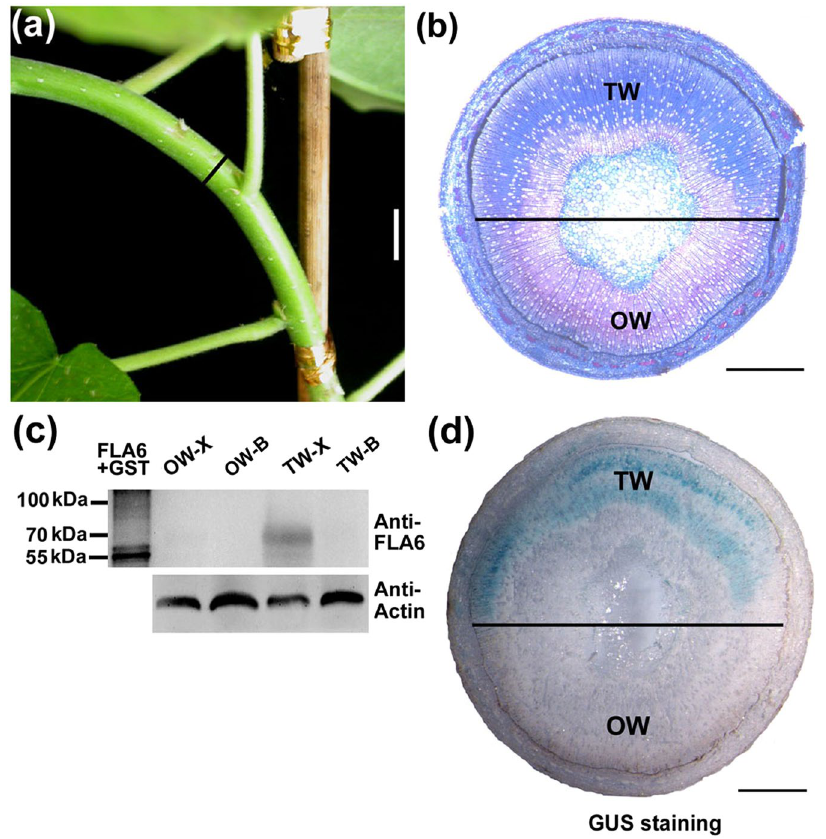
Figure 1. PtFLA6 expression analyses during TW formation. ( a ) TW induction by mechanical stress. Two- month-old wild type poplar plants (Shanxin yang) grown in greenhouse were bended for two weeks. The black vertical bar indicates the part to be taken for analyses. Scale bar = 1 cm. ( b ) Sections of bended stems were stained with safranin-O and astra-blue. TW was stained into blue. The horizontal line indicates the division between TW side and OW side. TW, tension wood; OW, opposite wood. Scale bar = 1 mm. ( c ) Western blotting analysis of PtFLA6 protein during TW formation. A total amount of 15 µ g proteins was separated by SDS-PAGE and hybridized with anti-PtFLA6 antibodies (Anti-FLA6) or plant actin antibodies (Anti-Actin). FLA6 + GST, fusion protein for antibody production; OW-X, xylem tissues in the OW side; OW-B, the bark tissues of OW side; TW-X, xylem tissues in the TW side; TW-B, the bark tissues of TW side. ( d ) PtFLA6 promoter activity analysis during TW formation. Sections from the bended site of PtFLA6 promoter-GUS transgenic plants were used for GUS staining. Scale bar = 1